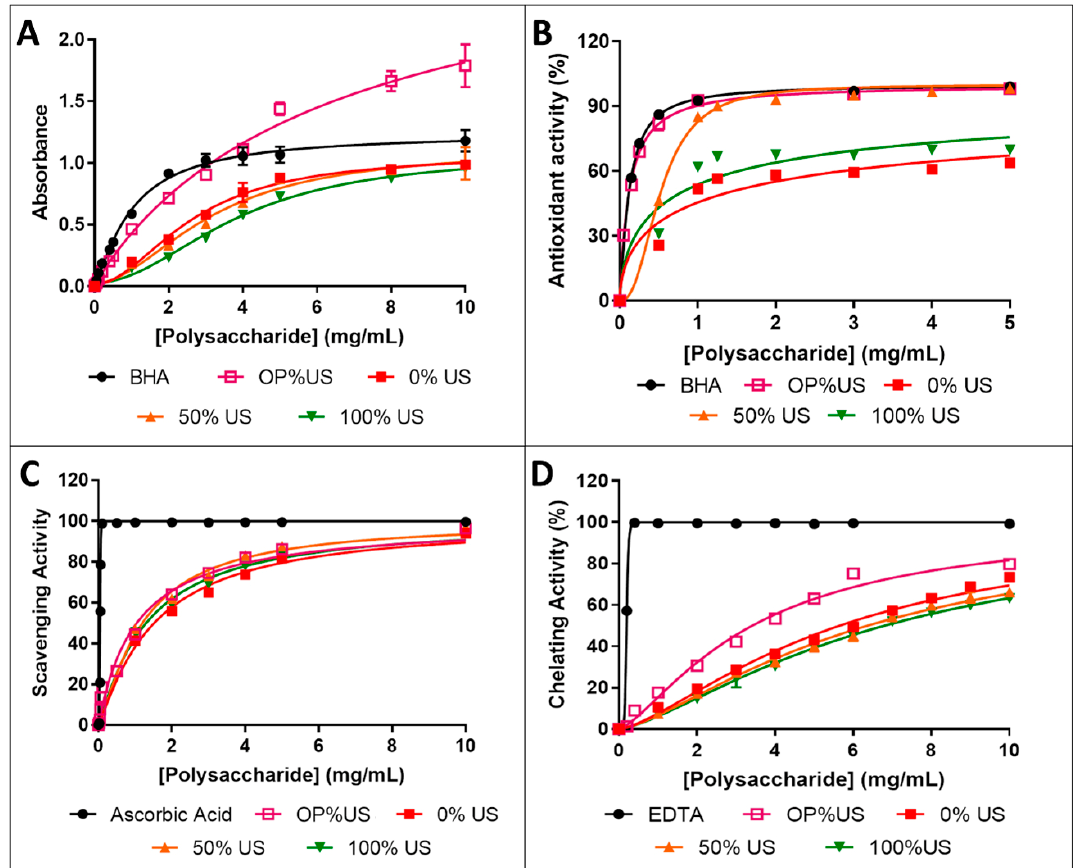
Figure 5. Antioxidant activity of 0, 50, 100% US, and OP%US as a function of concentration in comparison with the control: total antioxidant capacity ( A ), β -carotene bleaching ( B ), ABTS radical scavenging ( C ), metal-chelating power ( D ).